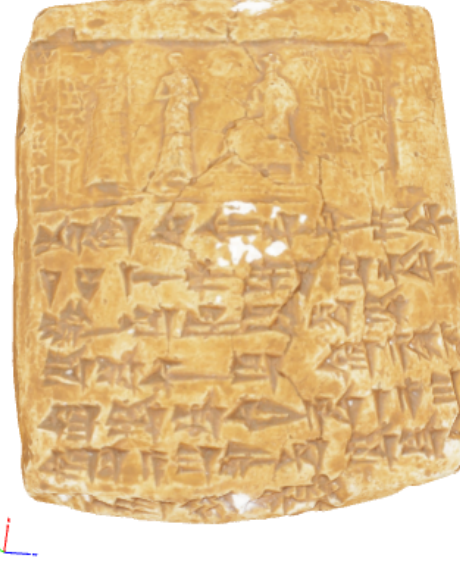
Figure 5: Model of the tablet from Ugarit - 50 mm lens